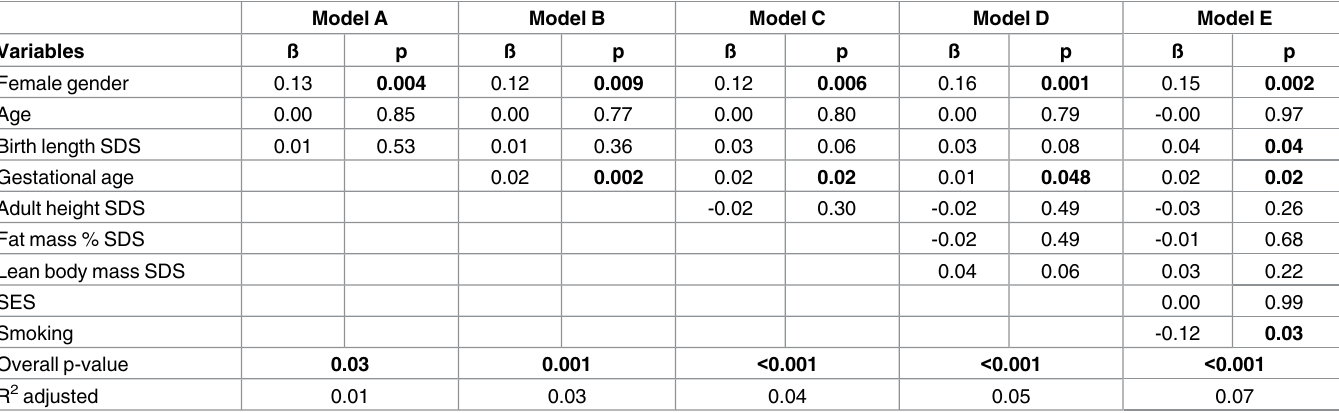
Table 2. Multiple regression analysis for variables associated with leukocyte telomere length at 21 yearsof age—Analysis including birth length.